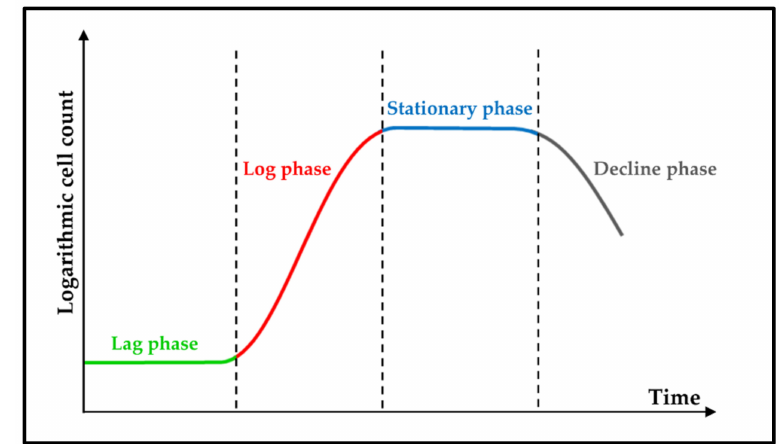
Figure 1. Different phases of biogas formation in a batch